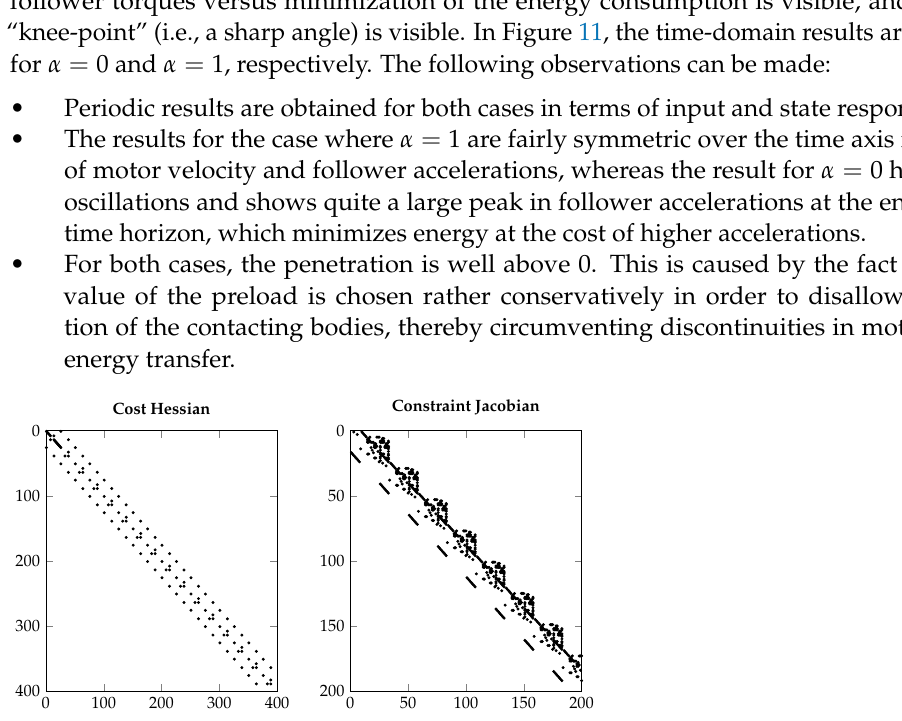
Figure 9. Zoom-plot of the block-diagonal cost Hessian and constraint